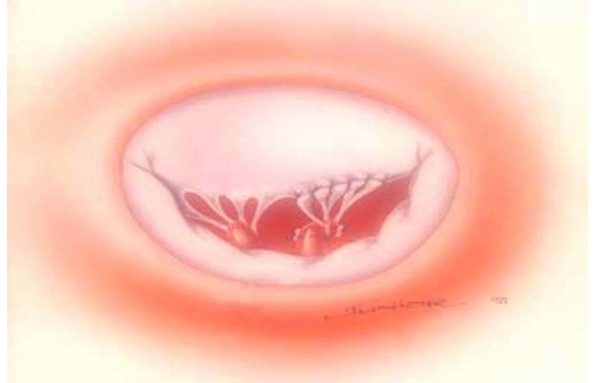
Fig. 4 – Intraoperative aspect after suture of the graft on the papillary muscle and the anterior leaflet of the mitral valve